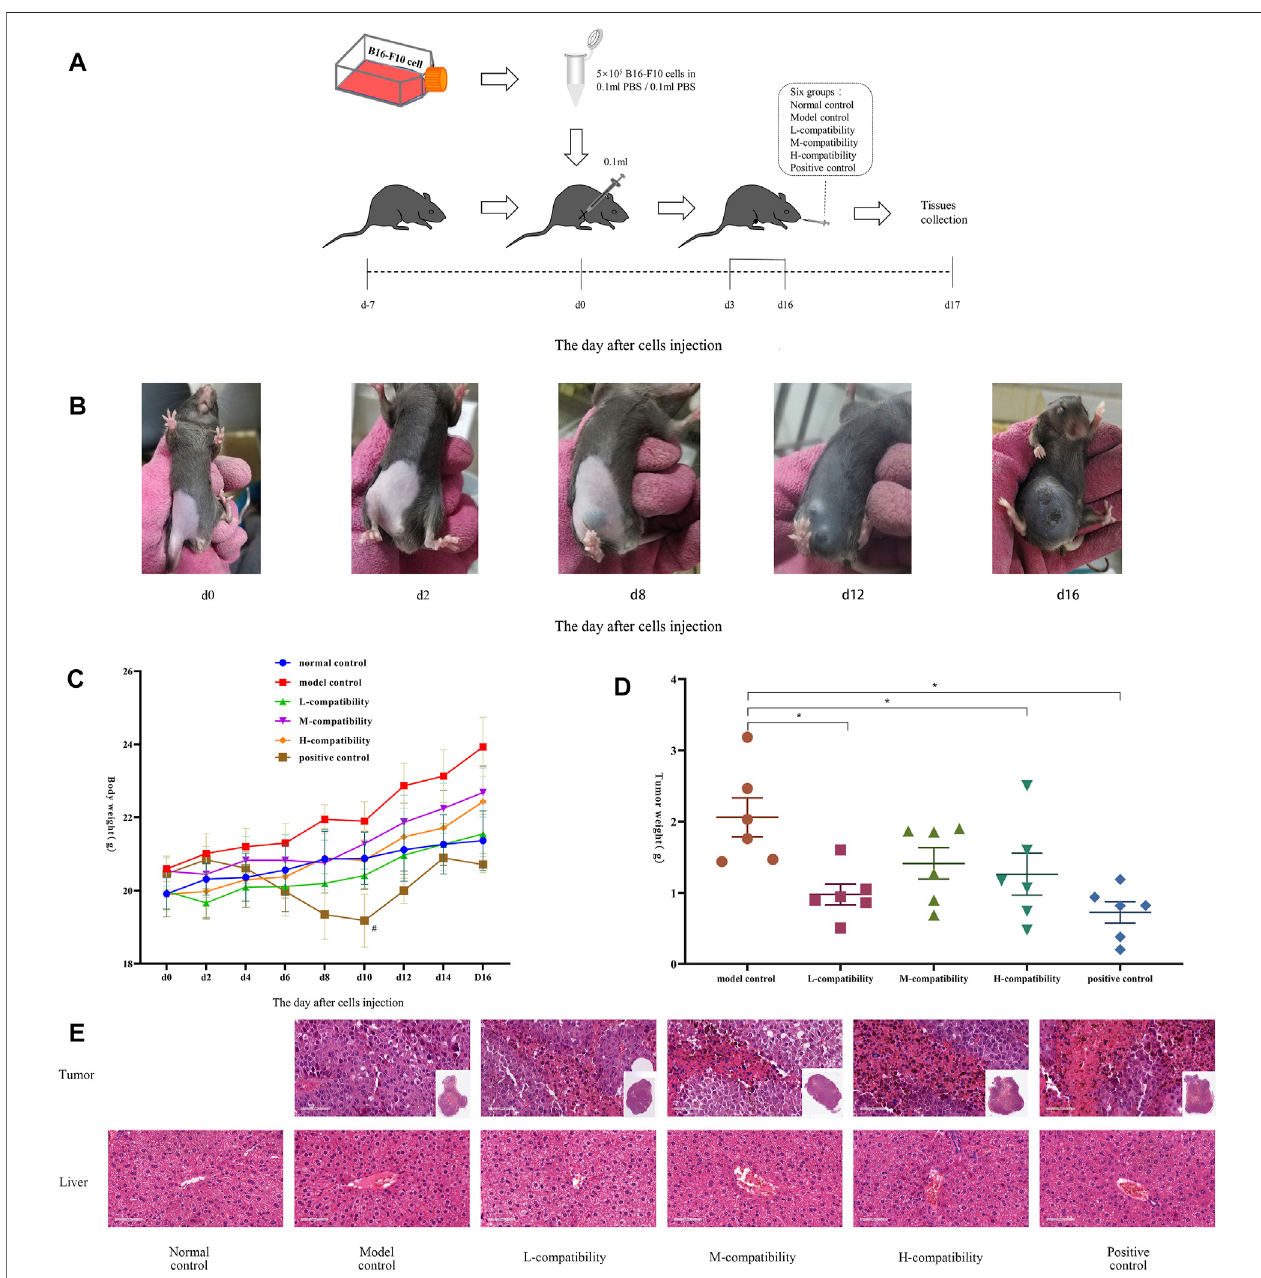
FIGURE 4 | Compatibility of AMD and RTD inhibited B16-F10 melanoma growth. (A) Progress of animal experiments. (B) B16-F10 tumor in MCG at different time points. (C) Body weight of mice at different time points. (D) Mean weights of the dissected tumors. (E) H&E staining in tumor and liver tissues (200x). n = 6. *p < 0.05 versus MCG. # p < 0.05, compared with